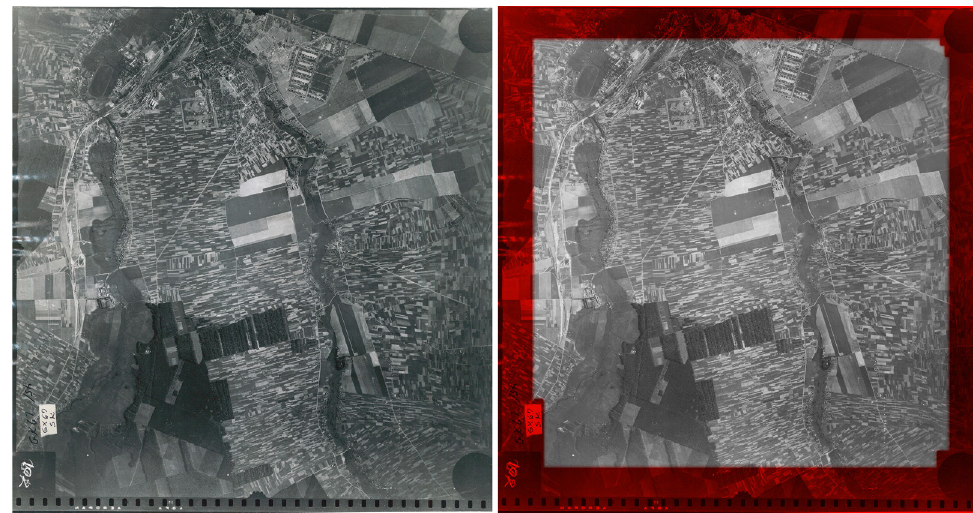
Fig. 5. German aerial photograph from 1944 Lublin – Dziesiąta, Głusk, Majdanek . On the left – the original scan, on the right: the photo after graphic processing – the area marked in red has been converted to an “alpha” transparency channel, 23% of the original size. Compiled images of the NARA collection